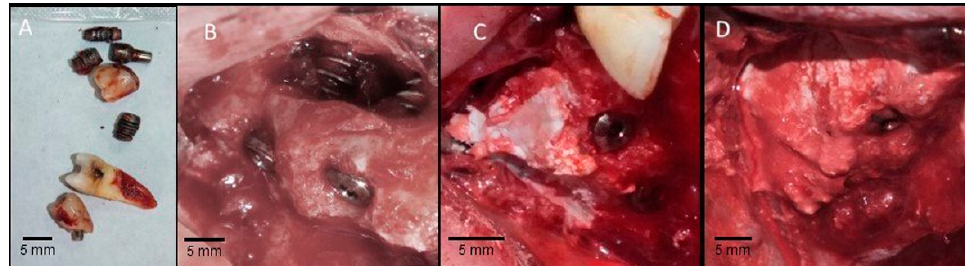
Figure 2. The clinical procedure used in the present case to increase the volume of the buccal bone in the whole area planned for placing the new implants. ( A ) Old implants were removed; ( B ) placement of new implants showing the sinus window; ( C , D ) Paste-CPC was used as a bone graft to close the sinus window, filling it up to cover the implants and the missing buccal plate in the mesial implant and flap after healing.